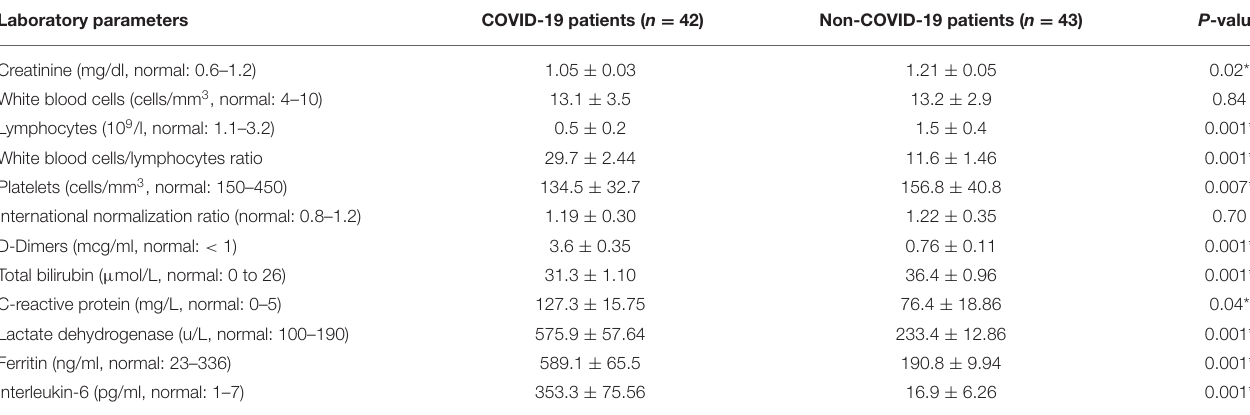
TABLE 3 | Laboratory parameters of forty-two COVID-19 patients and forty-three non-COVID-19 patients with acute respiratory distress syndrome. Laboratory